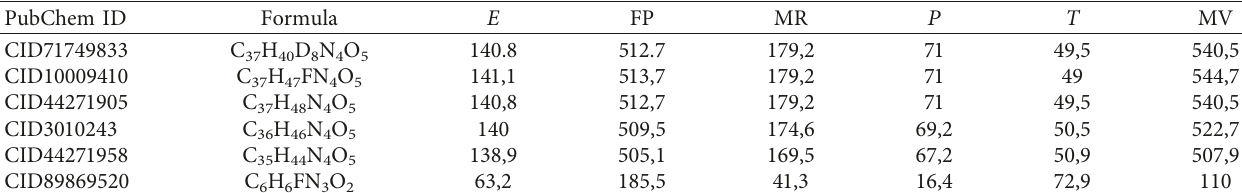
Table 2: The physicochemical properties of potential drugs to be used in the treatment of COVID-19. PubChem ID